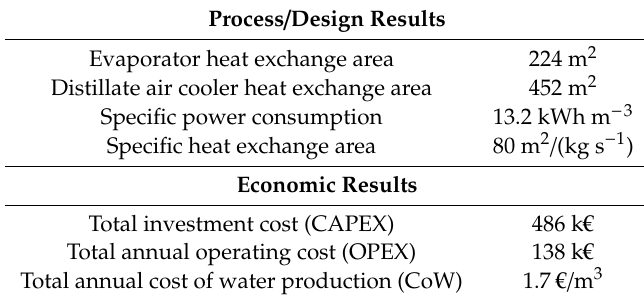
Table 6. Results from basic design, CAPEX and OPEX estimation for the MVC desalination of waste geothermal